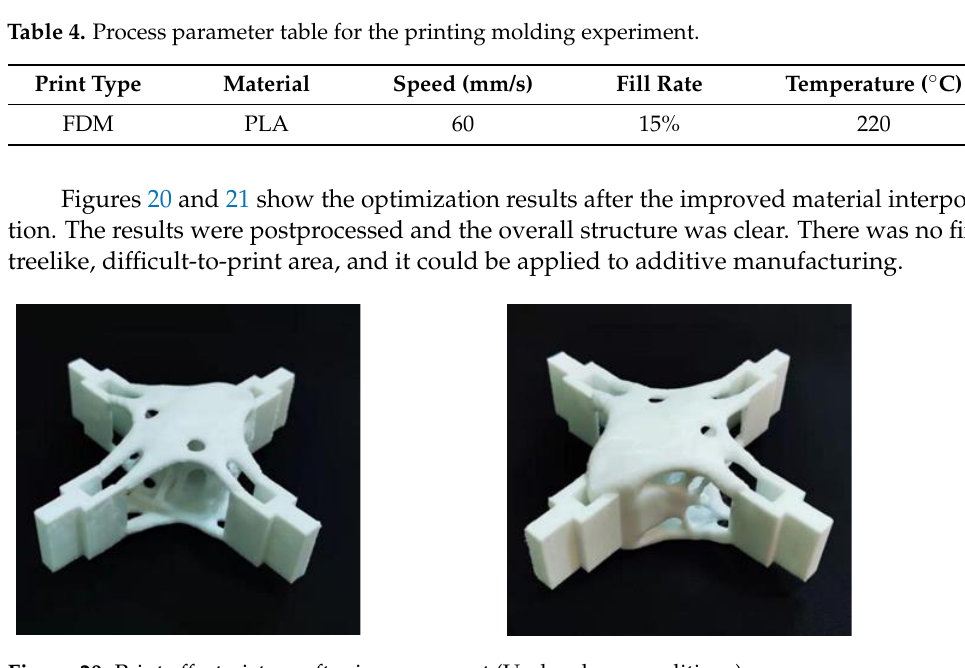
Figure 20. Print effect picture after improvement (Under shear conditions).